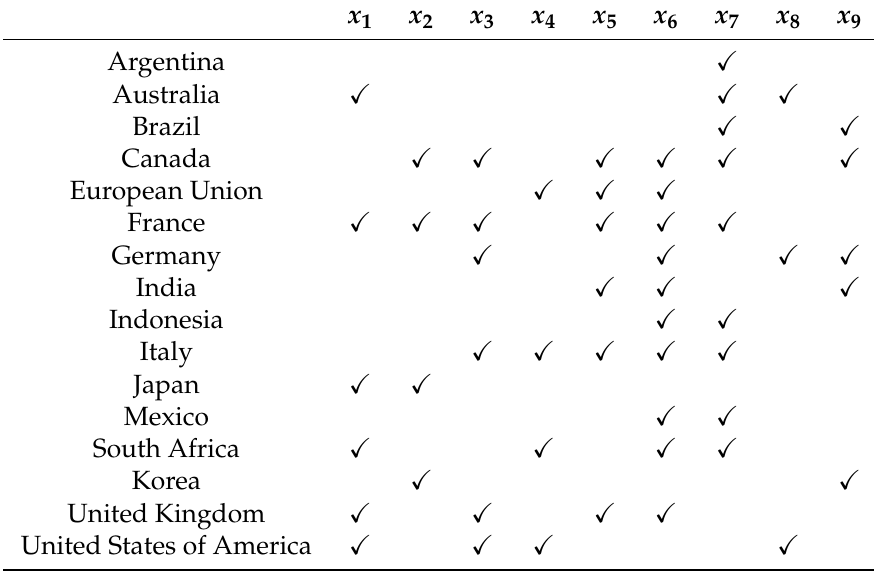
Table 4. Relevance of the independent variables of model (1), from which the GDP depends, for each country; for an explanation of how variable relevance was determined, see Section